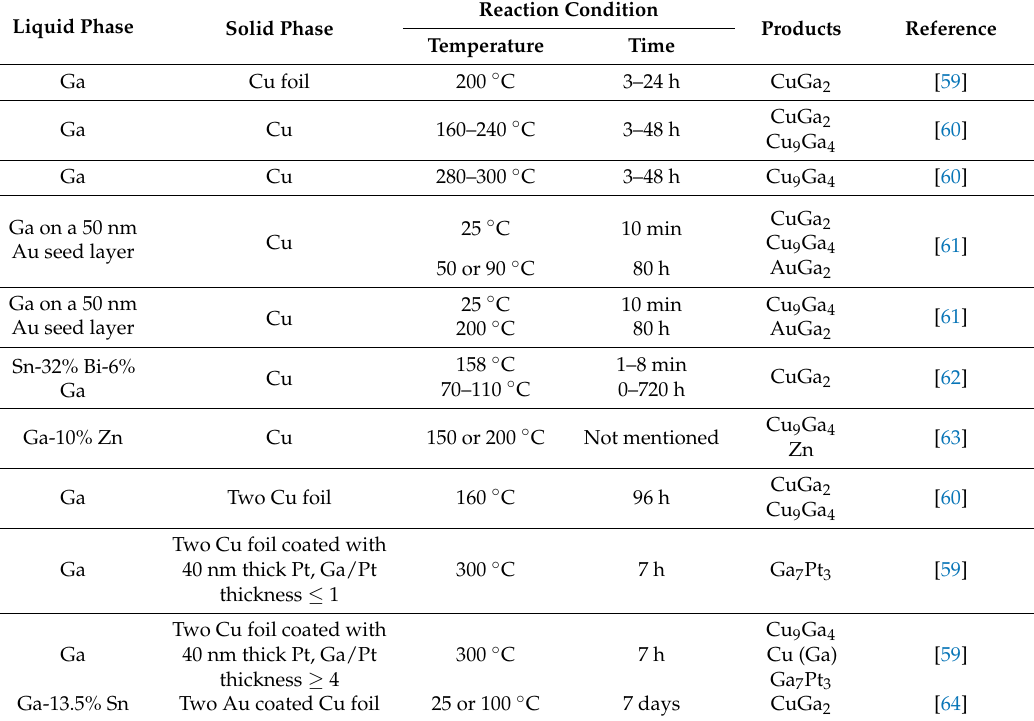
Table 3. Summary of reactions between liquid Ga-based alloys and Cu substrates.